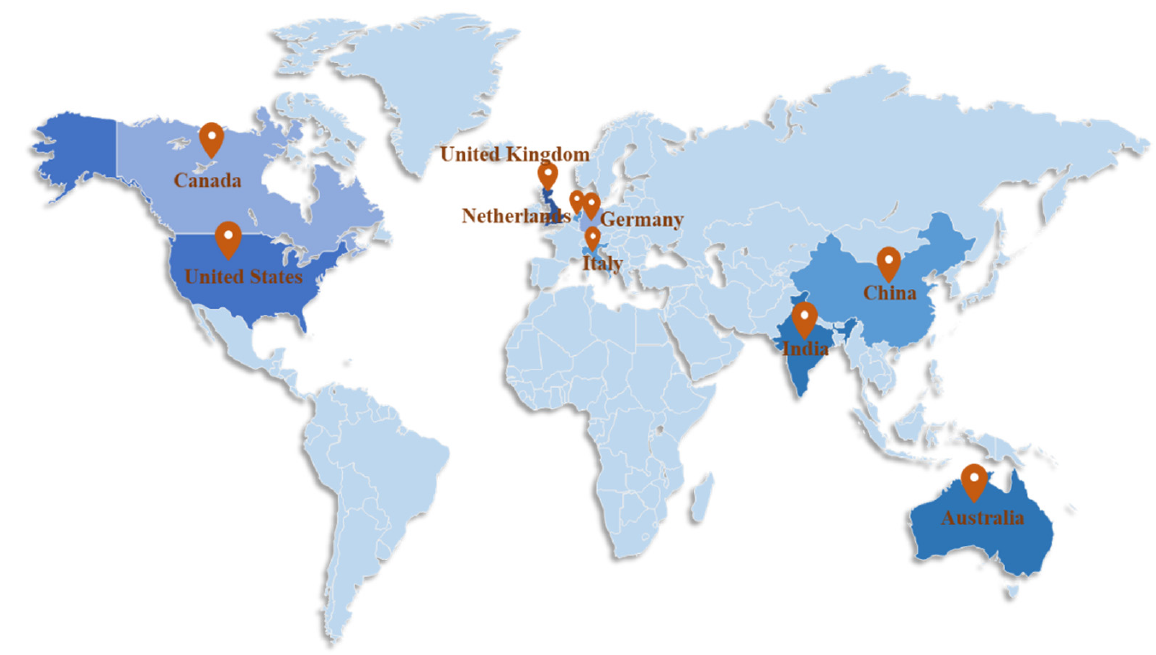
Figure 5. Global geographic distribution of digital healthcare publications. Figure 6 is the national cooperation network. Each node in the figure represents the number of papers published in the country where the first author belongs, and the thickness of the line between the nodes represents the strength of cooperation between the two countries. From Figure 6, many countries have formed a complex and close cooperation networks in the field of digital healthcare. The United States, the United Kingdom, Germany, China, and Japan published a large number of papers, and established complex cooperation networks with other countries. Estonia is one of the countries with high centrality. Estonia has an area of only 45,000 square kilometers and a population of 1.319 million. Compared with the United States, Britain, Germany, China and Japan, Estonia does not have an advantage in terms of resources. But Estonia has been using the latest information technology to promote the process of digital society. With the full promotion of the government, Estonia is one of the most digitally advanced countries in the European Union and has established an efficient, safe and transparent social ecosystem. Encouraging health care providers to use new digital technologies is the key to the success of Estonian e-health policy [97]. In 2008, Estonia established a nationwide electronic medical system to improve the medical quality and efficiency of the public medical system [98]. In 2010, as a supplement to the electronic medical system, Estonia created a centralized paper-less prescription system for the issuance and processing of medical prescriptions. Currently, 99% of medical prescriptions in Estonia are processed online